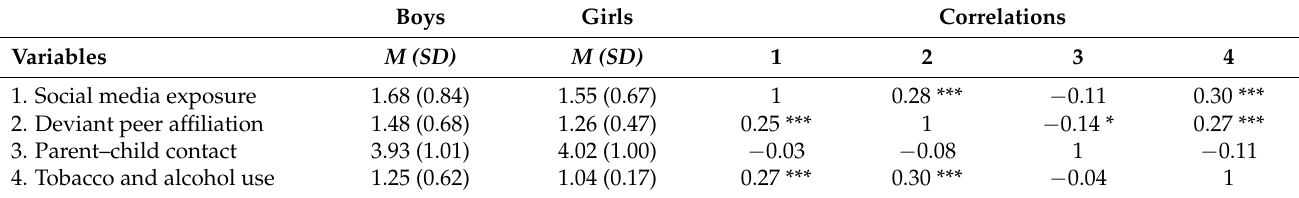
Table 1. Descriptive statistics and correlations among study variables.